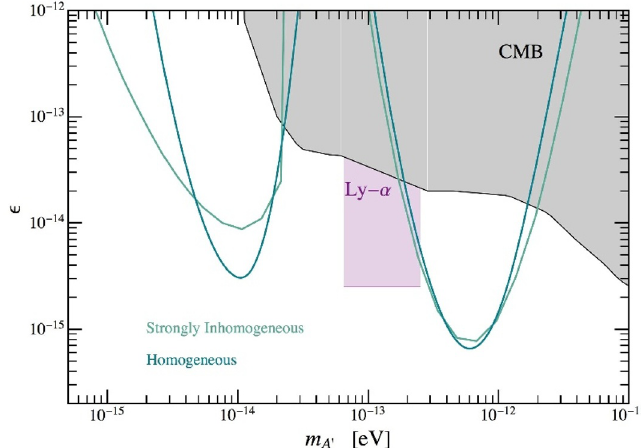
Figure 8 . Bound that could be derived assuming " inj between z 2 [6 ; 10] is less than 1 eV / baryon, and assuming reionization proceeded either homogeneously ( i.e. all (cid:1) b ionized at same rate), or in a strongly inhomogeneous manner (ionizing over-densities (cid:12)rst, and under-densities